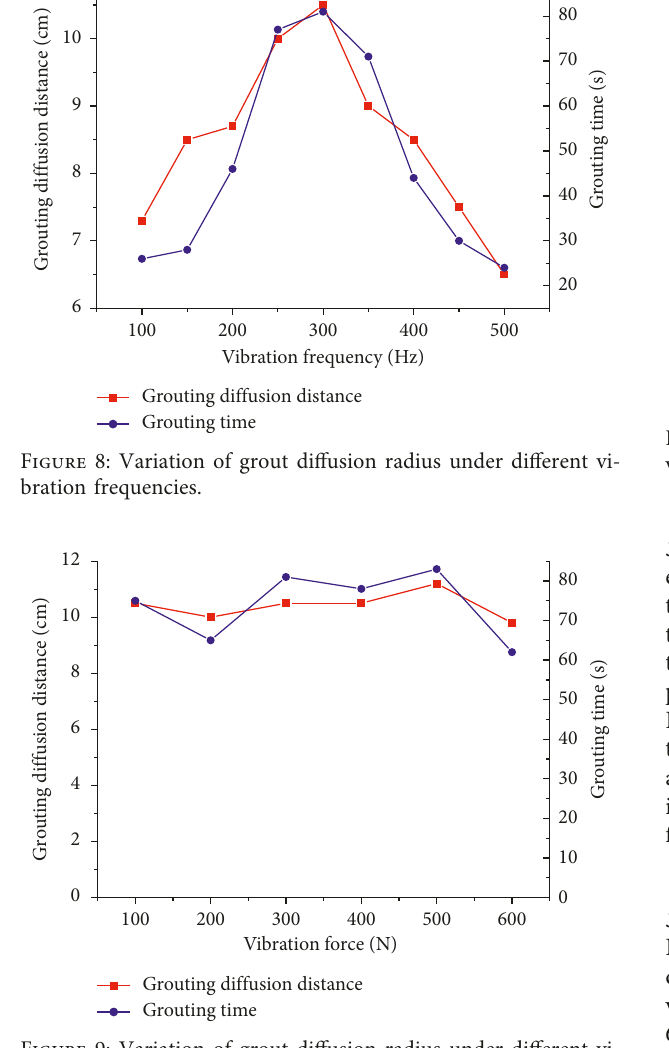
Figure 9: Variation of grout diffusion radius under different vi- bration forces.